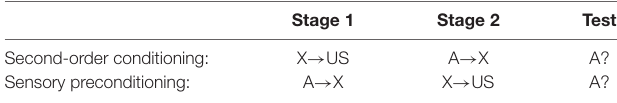
TABLE 1 | Higher-order conditioning procedures.